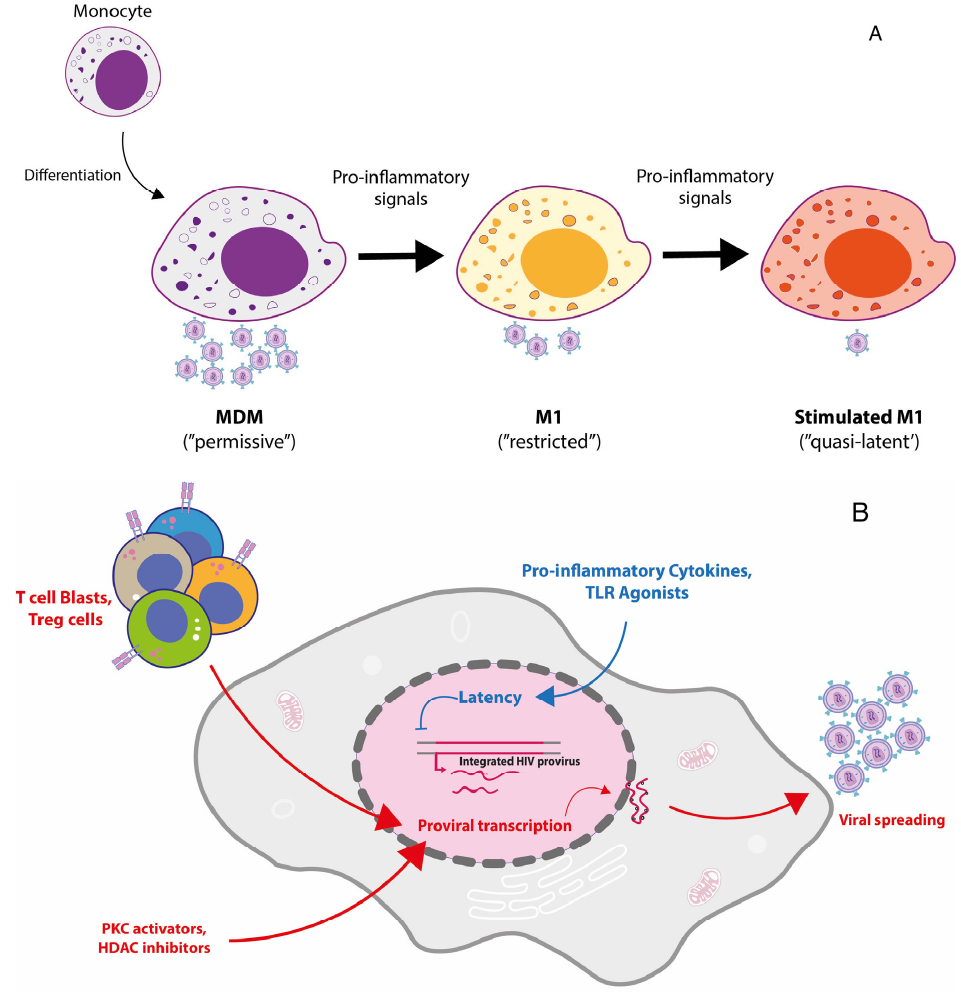
Figure 2. M1-MDM: a model of HIV-1 restriction suitable to be exploited as model of reversible HIV-1 latency. ( A ) Differentiation of circulating monocytes into MDM leads to their productive infection by HIV-1 (“permissive phenotype”), whereas their polarization into M1 cells induces a significant reduction in virus replication (“restricted phenotype”). Further stimulation of M1-MDM by different proinflammatory signals leads to an even greater reduction in their capacity to support virus replication approaching a state of proviral latency. ( B ) Incubation of restimulated M1-MDM with either T cell blasts, T regulatory cells or with selected pharmacological agents leads to reversal of proviral latency in MDM and viral